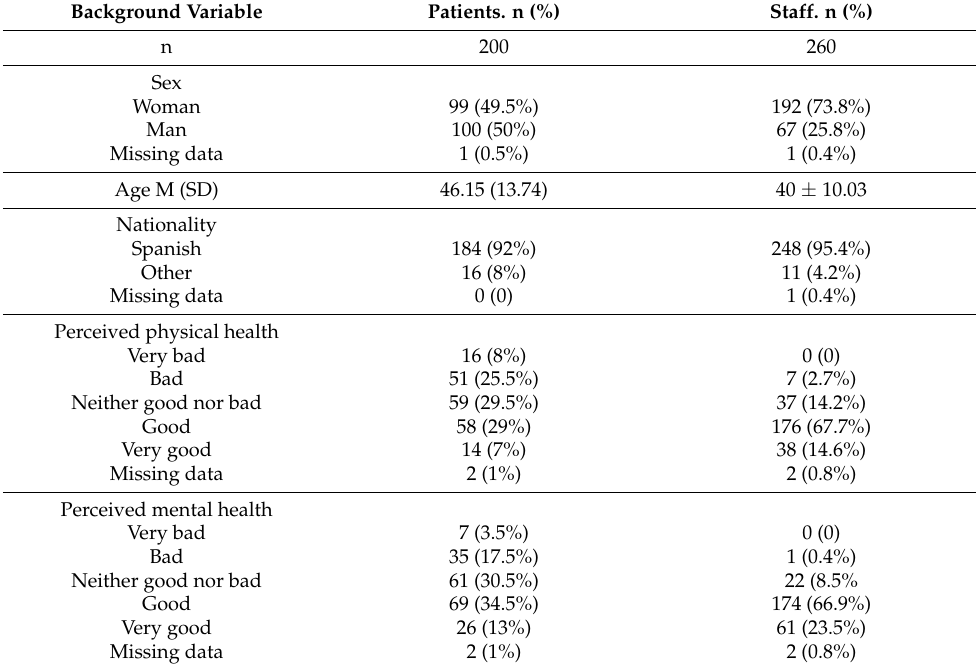
Table 1. Study groups’ sociodemographic